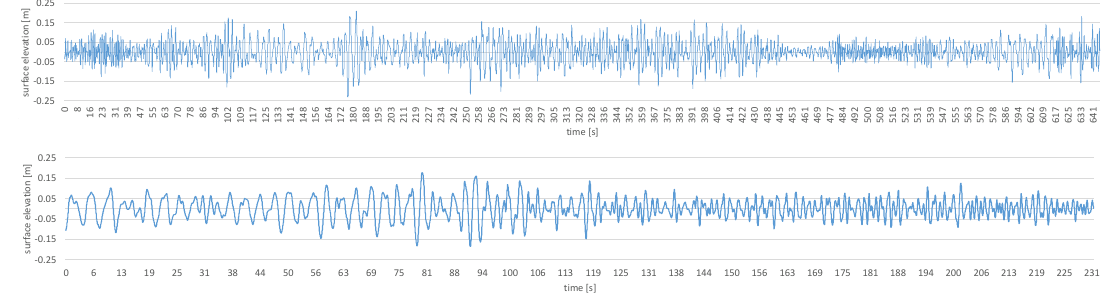
Figure 6. Training ( above ) and test ( below ) wave data in the applied 1:10